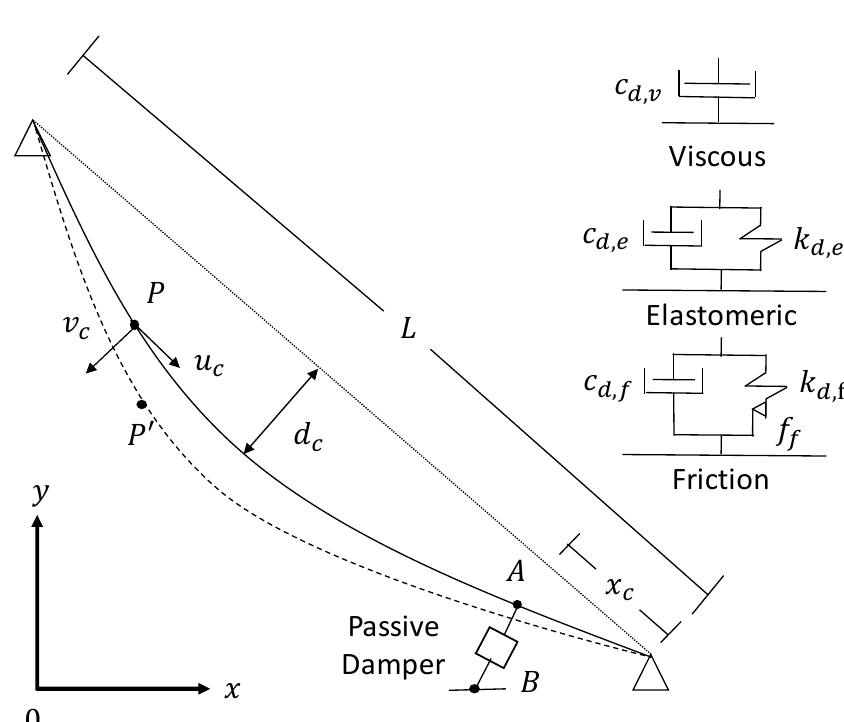
Figure 2. Damper-cable interaction model considered and mechanical model of each passive damper (viscous, elastomeric, and friction).